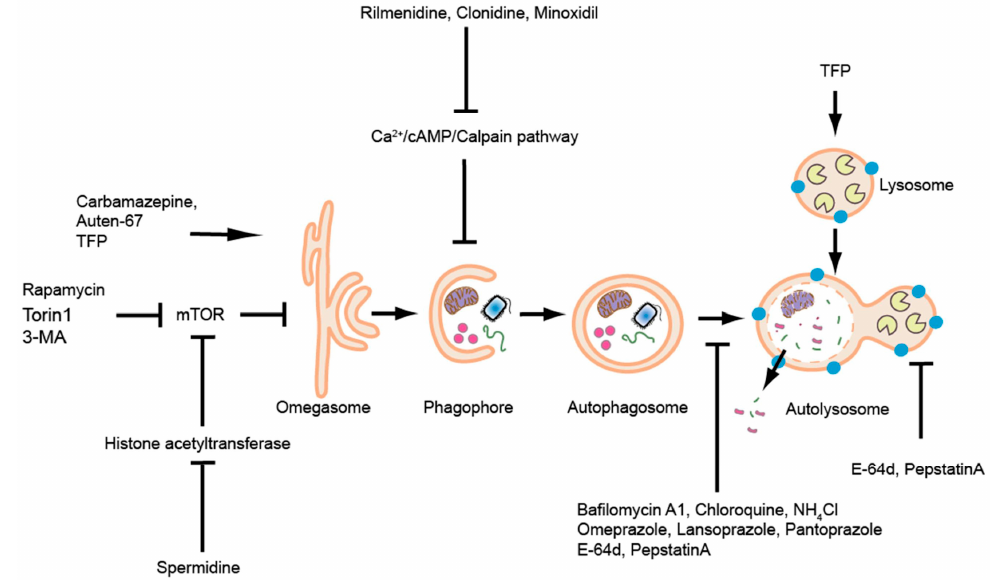
Figure 4. Schematic overview of the autophagic pathway and a partial list of reagents (reagents used beyond 2014, Table 2) that modulate autophagy in zebrafish are indicated.